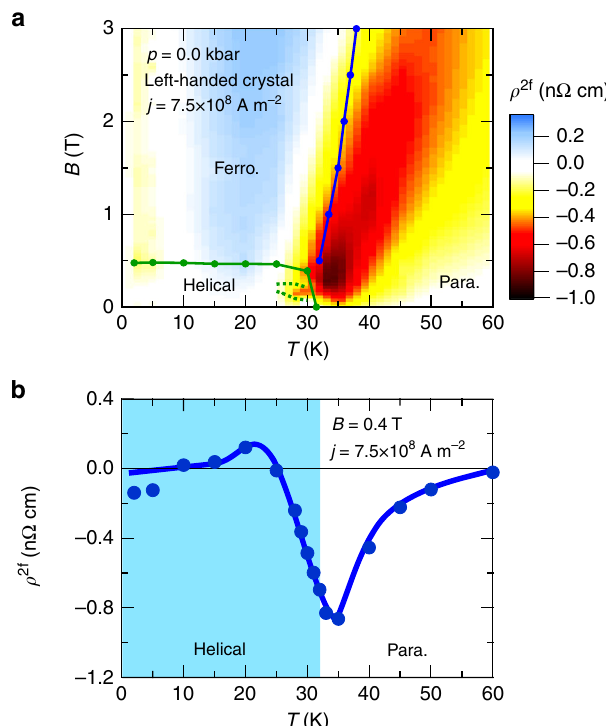
Fig. 3 Temperature dependence of electrical magnetochiral effect. a Contour mapping of second harmonic resistivity ( ρ 2f ) in left-handed MnSi in T - B plane. The green and blue lines denote the phase boundary enclosing the helical phase and the crossover line between the induced ferromagnetic and paramagnetic phases, respectively. For the ρ 2f anomaly around the narrow skyrmion-lattice phase region (denoted by a dotted green line), see Supplementary Fig. 4 and Supplementary Note 5. b Temperature dependence of ρ 2f at B = 0.4